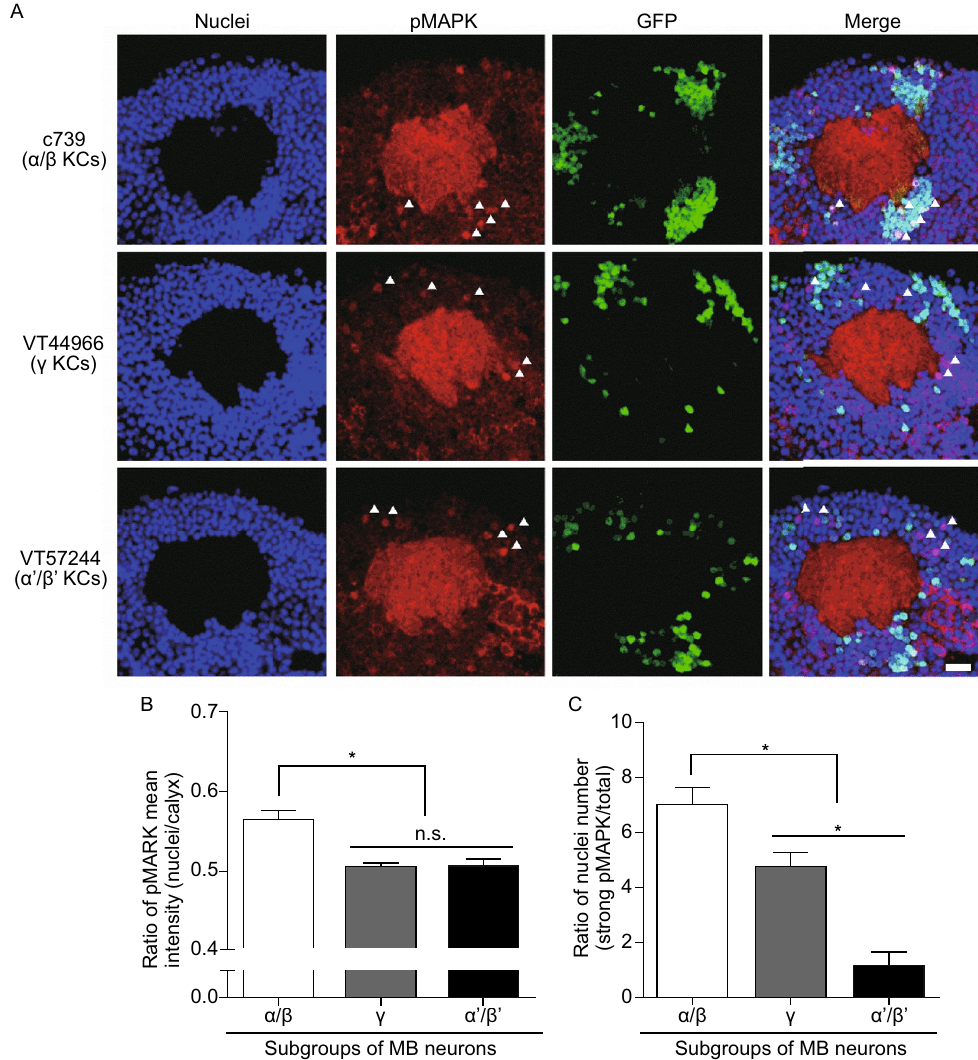
Figure 1. Distribution of nuclear pMAPK signal in three major types of MB neurons during consolidation . (A) Representative images of pMAPK signal in different types of MB neurons at 8-h after spaced training. Indicated Gal4 lines were crossed to fl ies with the genotype UAS-nlsGFP and detected by confocal imaging of whole adult central brain. Nuclei are indicated by blue color. pMAPK signal is displayed as red color. Gal4-drived expression of nlsGFP is shown as green color. Five representative nuclei with strong pMAPK signal are marked by white triangle. Scale bar is 10 μ m. (B) Statistical analysis as re fl ected in mean intensity ratio of pMAPK signal (Gal4-labeled nuclei vs. calyx). α / β MB neurons showed signi fi cantly higher ratio of pMAPK mean intensity than γ and α ’ / β ’ MB neurons. Bars, mean ± SEM ( n = 6 – 7); * P < 0.05. (C) Statistical analysis as re fl ected in nuclear number ratio of strong pMAPK signal (number of Gal4-labeled nuclei with strong pMAPK vs. number of Gal4-labeled nuclei). Nuclear number ratio of strong pMAPK signal in α / β MB neurons is remarkably higher than in γ and α ’ / β ’ MB neurons. Bars, mean ± SEM ( n = 6 – 7); * P <